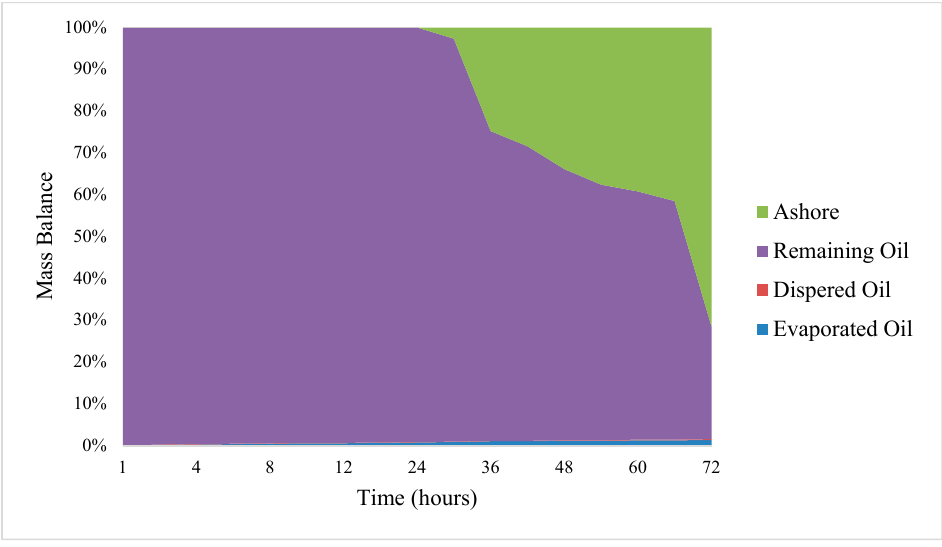
Figure 15. OSCAR model’s predictions of evaporated, dispersed, remaining (surface contaminant) and ashore (shoreline contaminant) IFO-380 oil after three days of tracking in Scenario #4 and started at 15:00. By comparison, a lesser proportion of the spilled oil remained on the water surface in Scenario #8 due to recovery actions. Nearly 61.8% (1730 L) and 65.5% (1834 L) of the spilled oil were recovered when oil was discharged at 14:00 and 15:00, respectively. The modeled recovered oil was more than the actual volume of spilled oil recovered, which was probably due to the lack of information reported by the response vessels. Overall, among the total number of forty studied scenarios, the results from four scenarios agree well with observations. The results indicate that the M/V Marathassa oil spill was most likely started between 14:00 and 15:00 on 8 April 2015. This spill was most likely a continuous slow release for an unknown period (assumed to be 22 h in this study) instead of an instantaneous release.